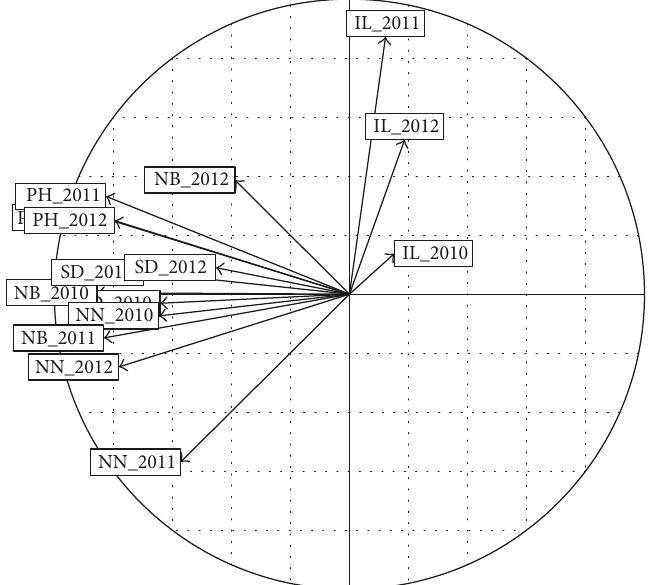
Figure 9: PCA correlation circle for phenotypic vigor traits over 3 years, 2010, 2011, and 2012, for 146 C. canephora trees in the field collection at the